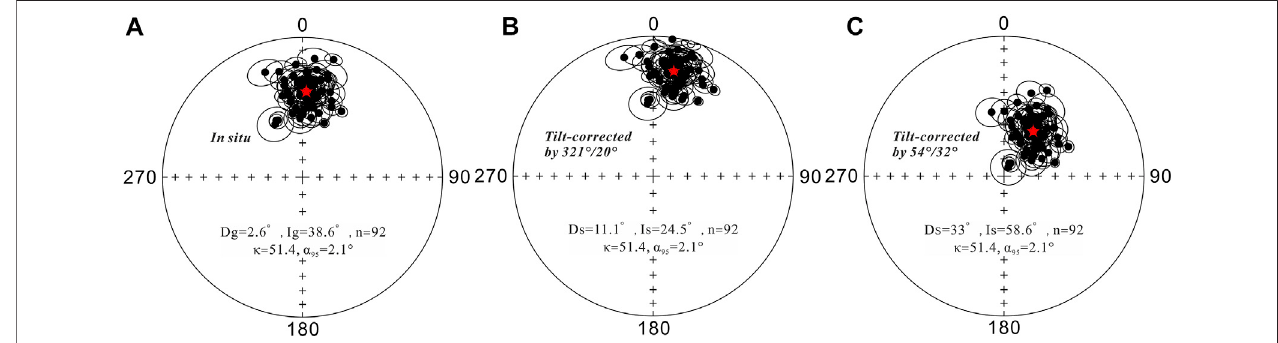
FIGURE 12 | Equal-area projections of the sample-mean directions from Type 1 and Type 2 granite before (A) and after bedding corrections with the bedding attitude (strike/dip) of E t (B) and J q (C) sandstones.